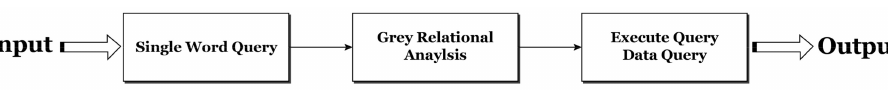
Figure 9. Simply consider a selected word value as main input model.